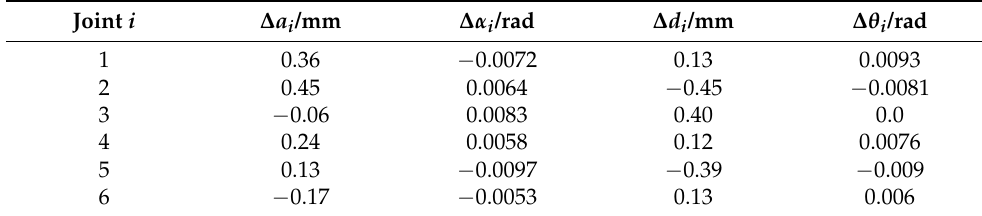
Table 2. Robot DH parameter error.